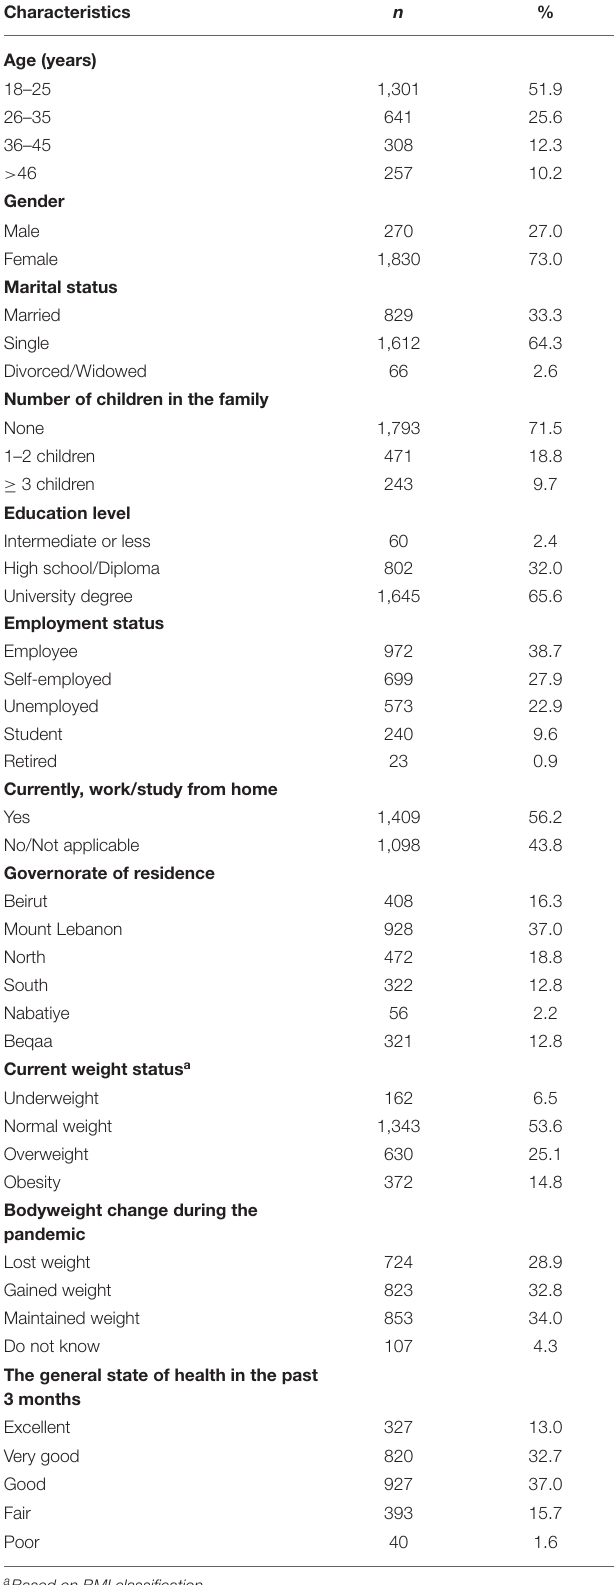
TABLE 1 | Demographic breakdown of surveyed participants ( n =